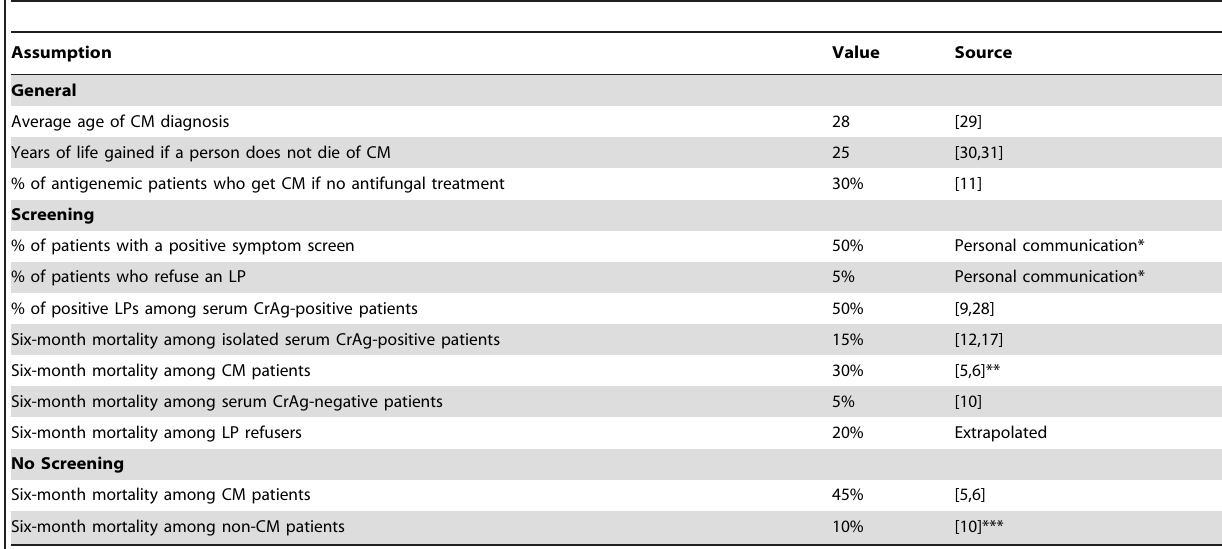
Table 2. Assumptions of a cost-effectiveness model for cryptococcal screening in